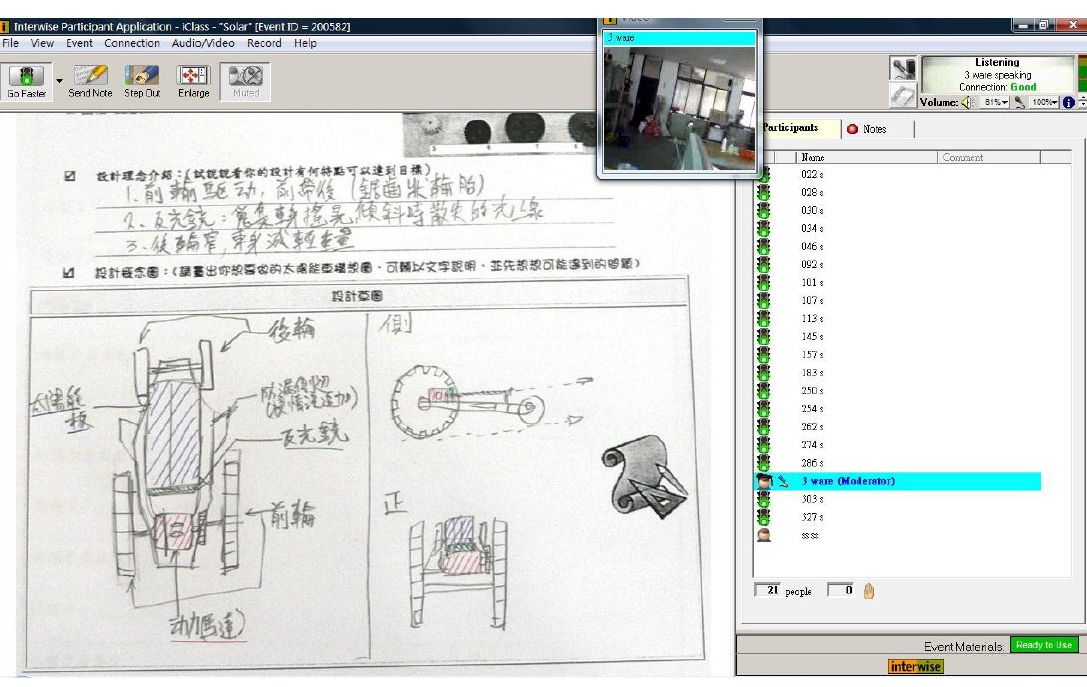
Figure 1 . Interwise interface in the online synchronous